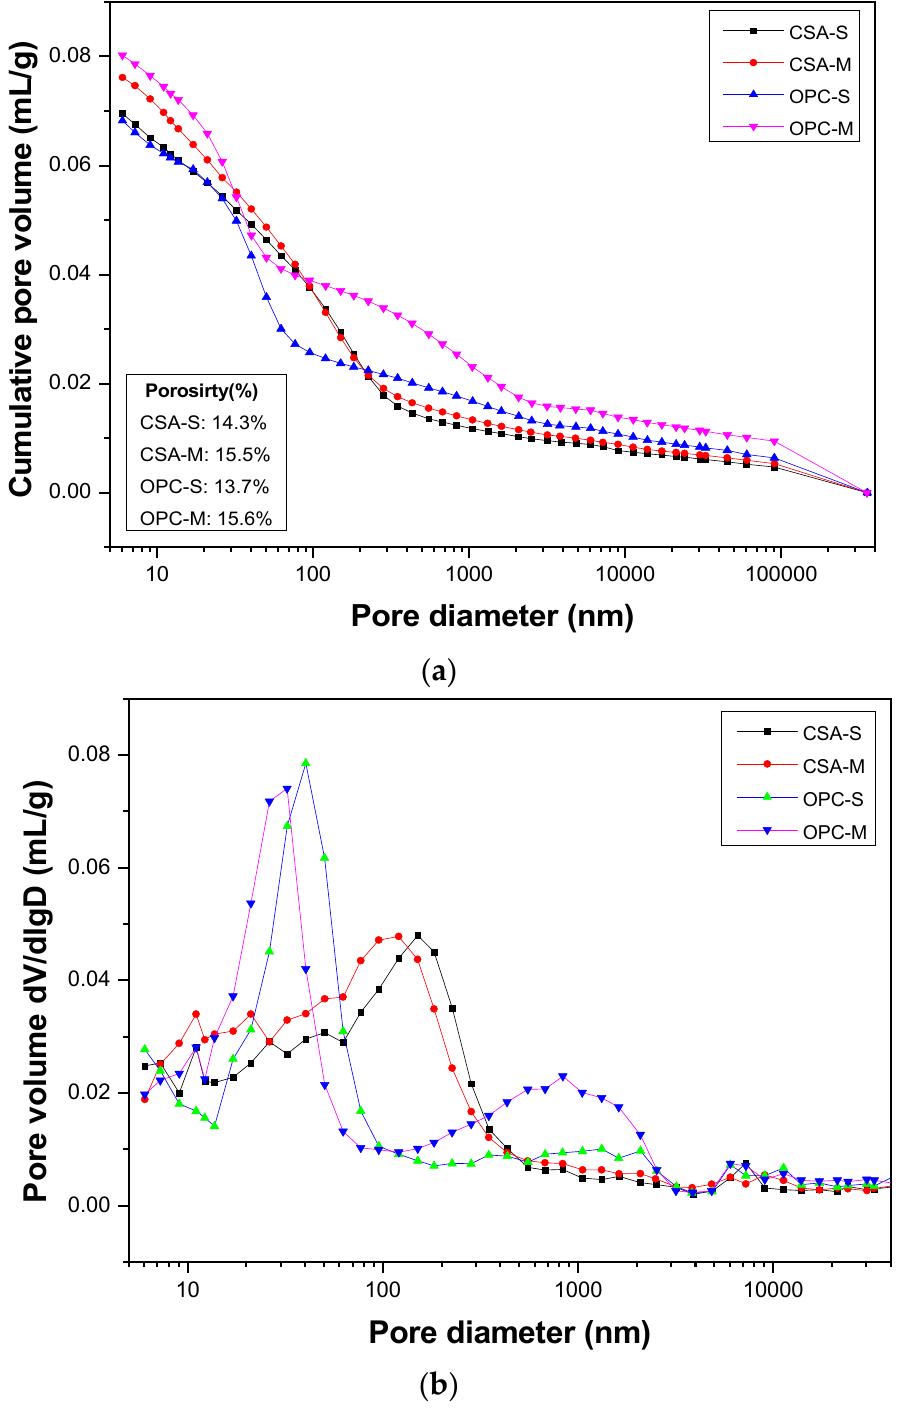
Figure 4. ( a ) Cumulative pore volume and ( b ) Pore size distribution (PSD) of selected samples after 2 months’ marine tidal